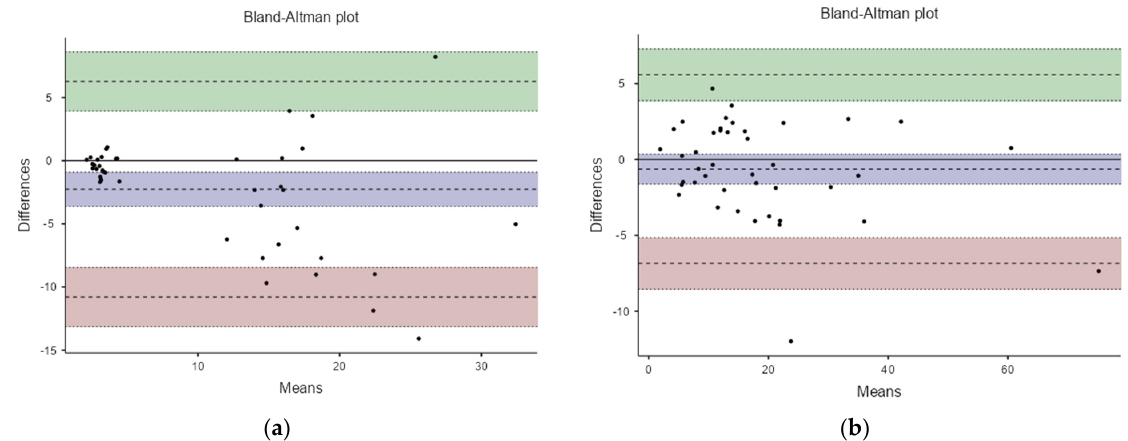
Figure 7. ( a ) Bland Altman (B&A) Plot between the ground truth and the computer tool of the alveolar space area with an upper and lower limit of agreement of 6.27 and − 10.8, with 95% of the values lying within the limit of agreement; ( b ) B&A Plot of the periodontitis group. Upper and lower limits are 5.58 and − 6.845, with 95% of the values lying within the limit of agreement.